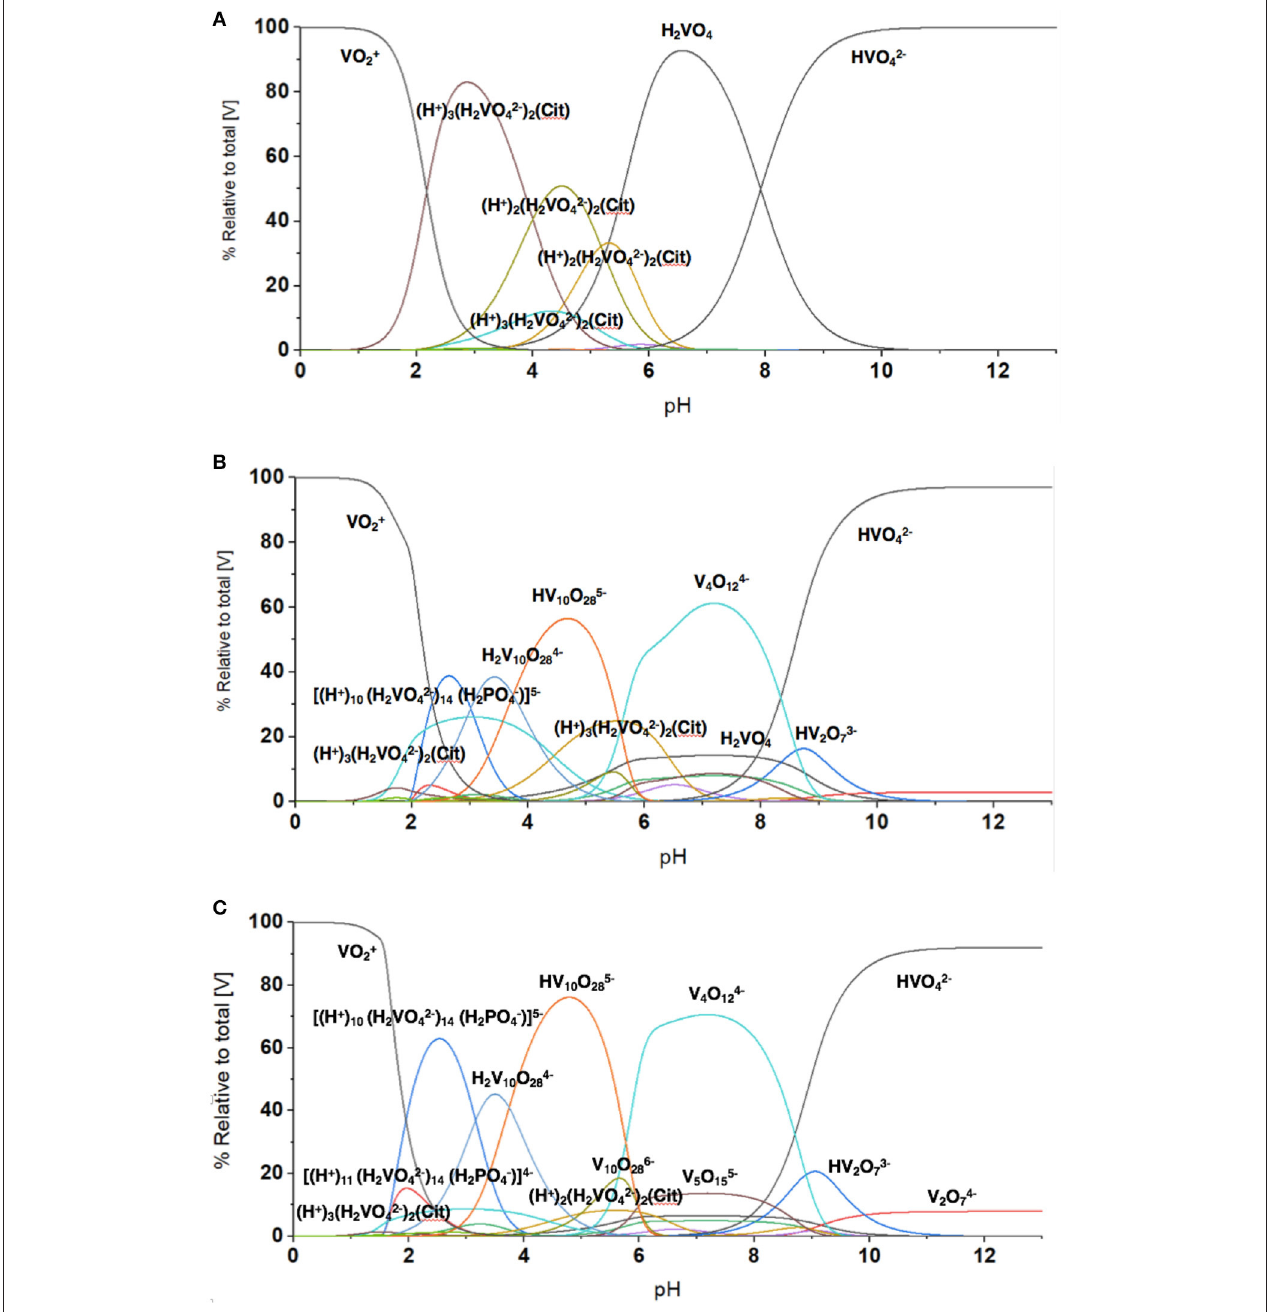
FIGURE 7 | The evaluation of the speciation at different vanadium concentration using HySS Program (vs. 2009) (Alderighi et al., 1999). The speciation diagram shown was calculated at several vanadium (V-atom) concentrations in the presence of 0.48mM citrate and 24mM phosphate found in the growth media and (A) 5.0 µ M vanadate, (B) 3.3mM vanadate, and (C) 10mM vanadate. Note, the concentrations of different species regardless of nuclearity are here shown in terms of